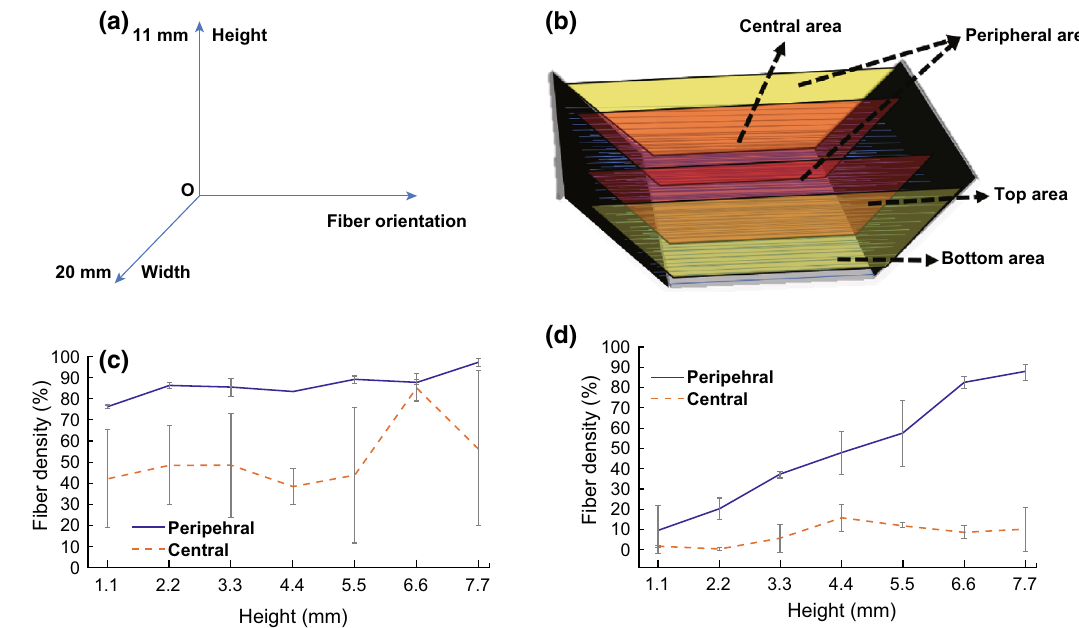
Fig. 5 a The coordinate system of the scaffold. b An illustration of different areas of a scaffold. The width of the two peripheral areas is 5 cm. The width of the central area is 10 cm. Fiber density gradients in the c 45 (cid:3) -collector and d 60 (cid:3)